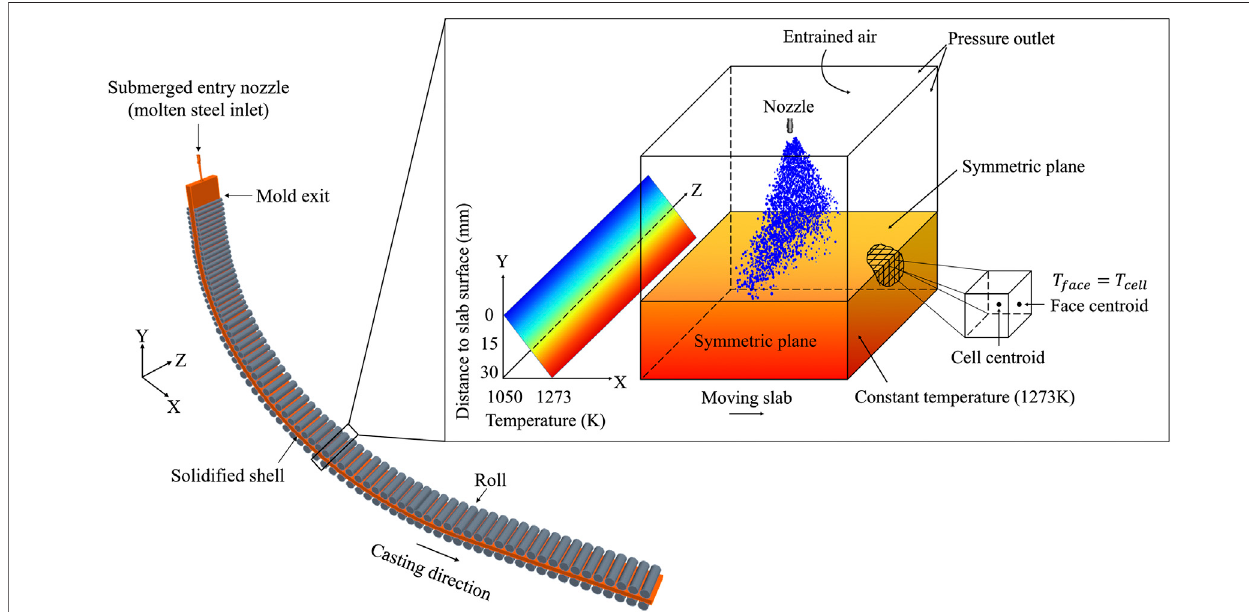
FIGURE 6 | Computational domain and boundary conditions for spray cooling